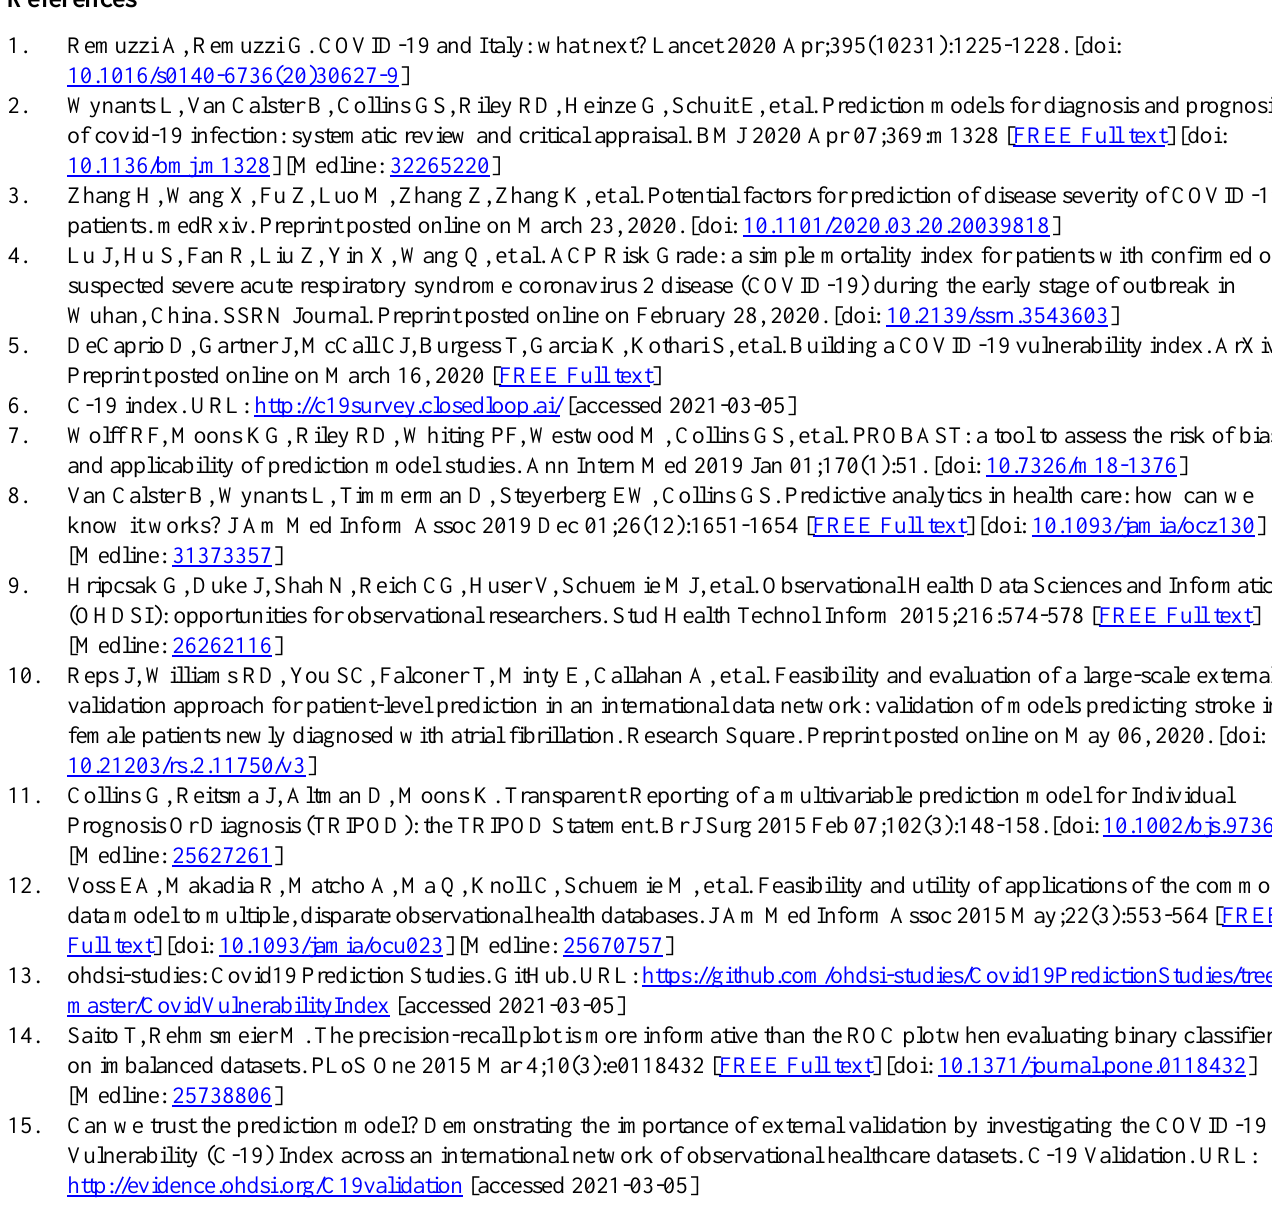
AU-ePBRN: Australia Electronic Practice–Based Research Network AUPRC: area under the precision recall curve AUROC: Area under the receiver operating characteristic